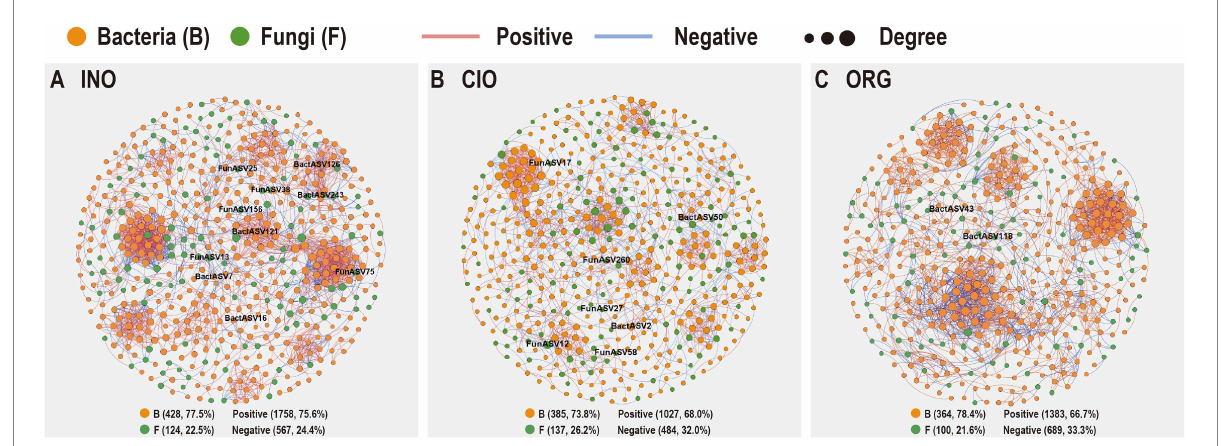
FIGURE 5 Co-occurrence network patterns of soil bacterial and fungal communities under the INO regime (A) , CIO regime (B) , and ORG regime (C) . INO, inorganic N-dominated; CIO, co-dominated by inorganic and organic N; ORG, organic N-dominated.